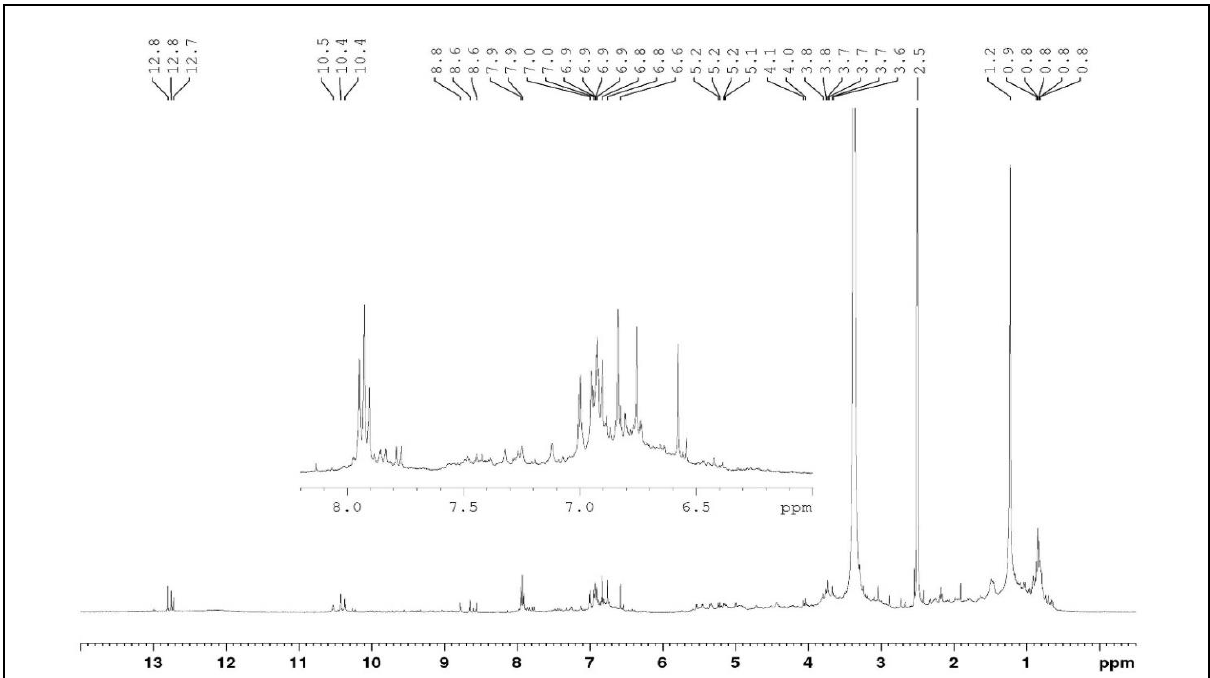
Figure 12. HSCQ contour map of flavonoids present in the ethanolic extract of F. chica leaves ( 1 H